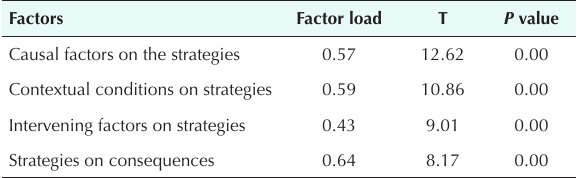
Table 3. The coefficients of the structural equation model of senior managers’ competencies